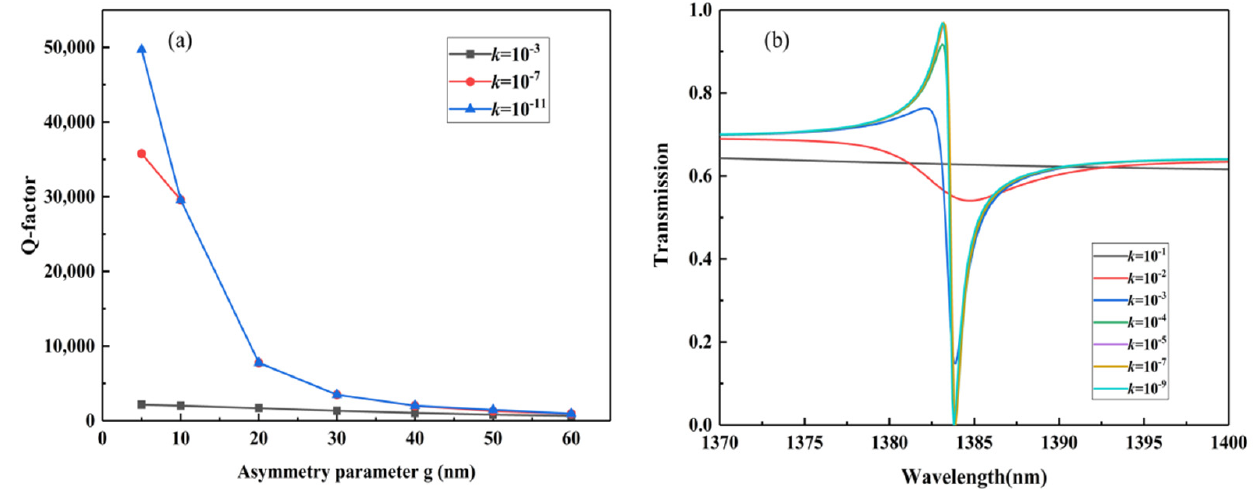
Figure 4. ( a ) Q-factor of F3 at k = 10 − 3 , 10 − 7 and 10 − 11 with different asymmetric parameters. ( b ) Transmission spectra of F3 with different extinction coefficients k at g = 40 nm.